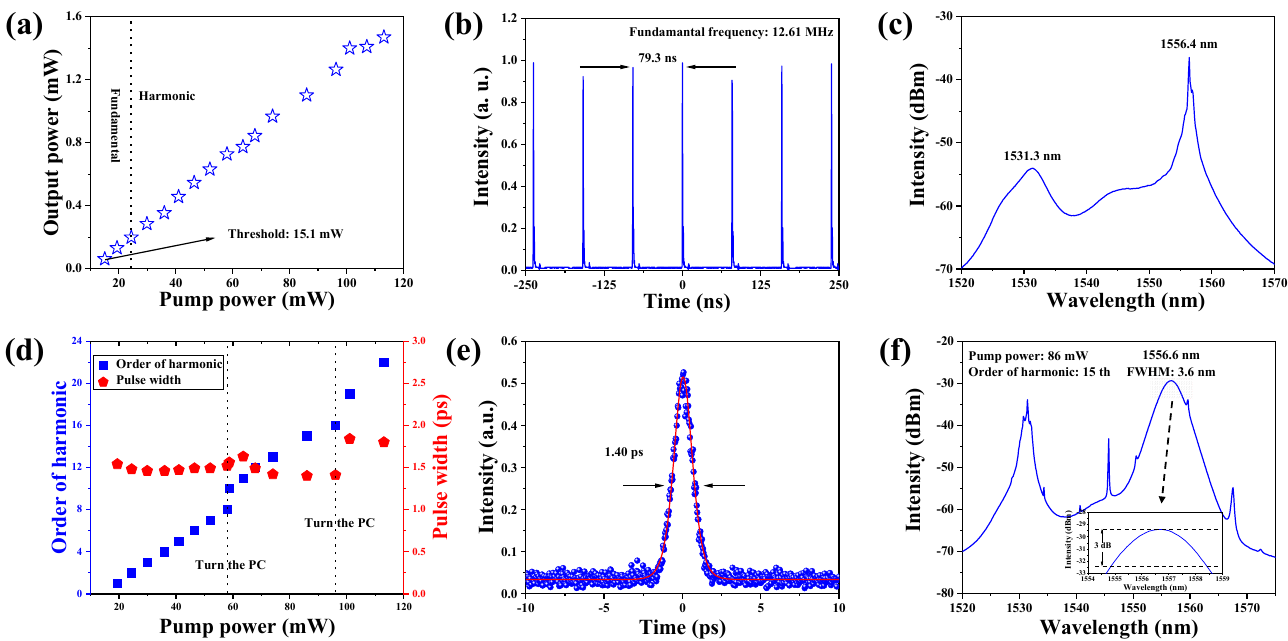
Figure 5. ( a ) Tendency of output power, ( b ) pulse trains under fundamental frequency, ( c ) optical spectrum under fundamental frequency, ( d ) trend of the order of harmonic and the pulse width changing with pump power, ( e ) auto-correlator trace of 15th harmonic pulse, ( f ) optical spectrum of 15th harmonic pulse. Table 1. Comparison of threshold of 1.5 μ m mode-locked fiber lasers based on different 2D materials.